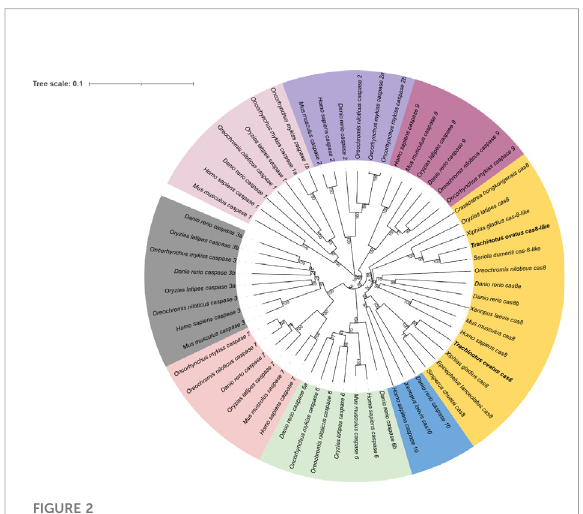
FIGURE 2 Genetic analysis. Syntenic comparisons of Caspase-8 genes in teleosts. Boxes represent genes, and different genes are identi fi ed by different colored boxes; lines represent intergenic regions.